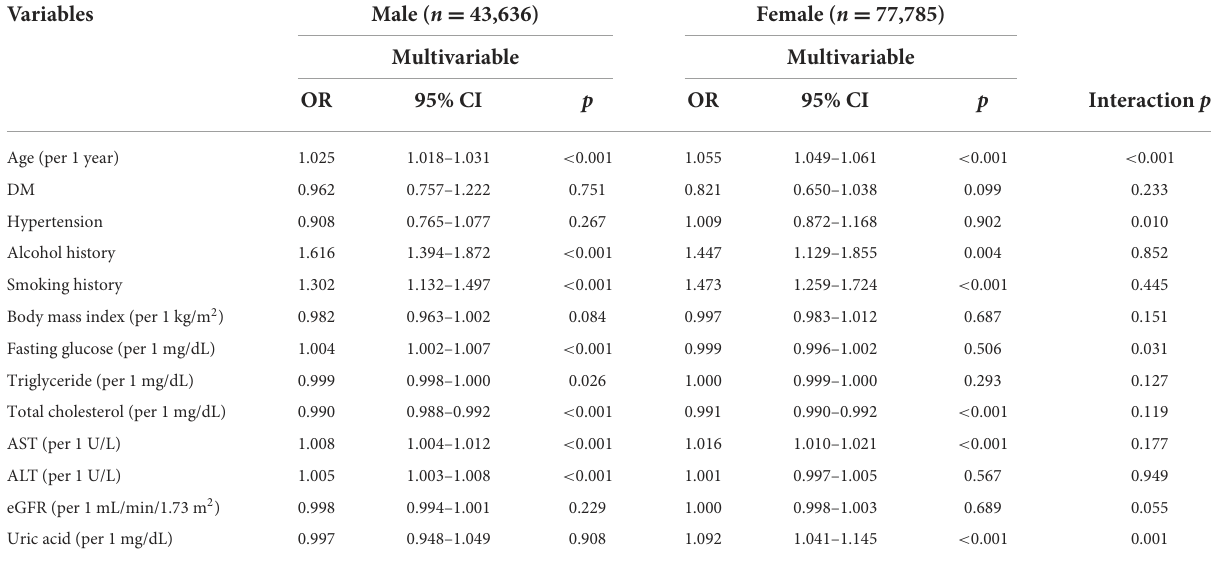
TABLE 4 Determinants for HCV by the presence of different sex using multivariable logistic regression